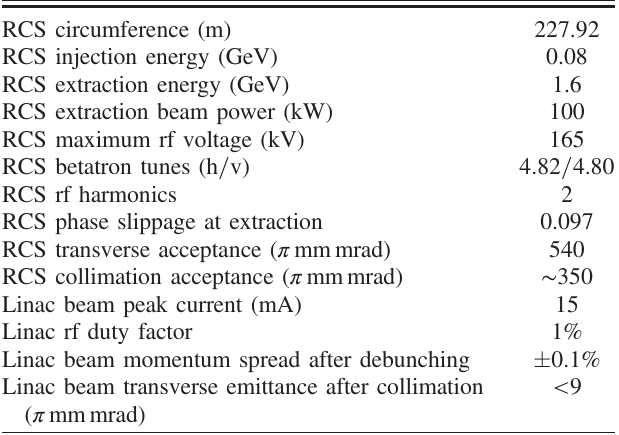
TABLE I. Some parameters of the CSNS accelerator complex at phase